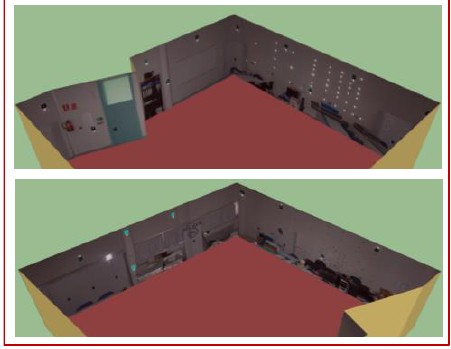
Figure 5: The 3D building interior is textured with the orthoimages.